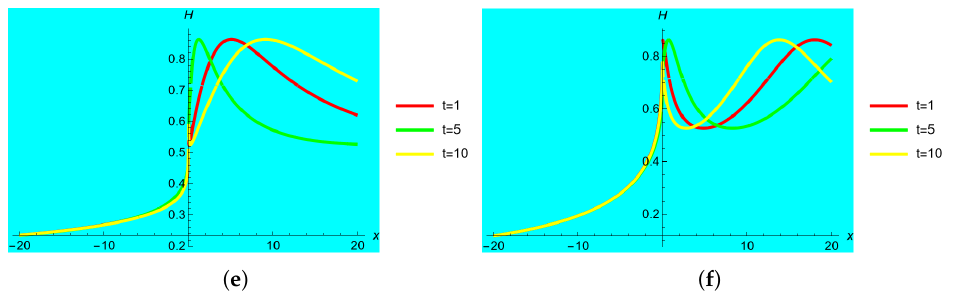
Figure 4. New exact solution by Nucci’s method (96) for the values of α = − 0.5, κ = 0.2, ω = 0.5, δ = 0.01, γ = − 2, ϕ 1 = 2.5. ( a ) 3-D wave profile at fractional order ζ = 0.2. ( b ) 3-D wave profile at fractional order ζ = 0.5. ( c ) Contour wave profile at fractional order ζ = 0.2. ( d ) Contour wave profile at fractional order ζ = 0.5. ( e ) 2-D wave profile at fractional order ζ = 0.2. ( f ) 2-D wave profile at fractional order ζ = 0.5.